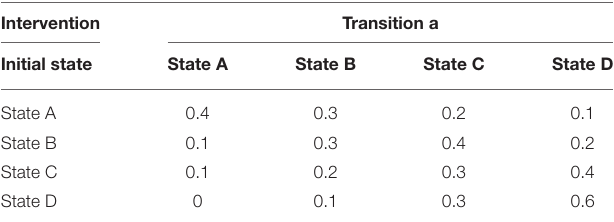
TABLE 2 | Probabilities of transition between intervention